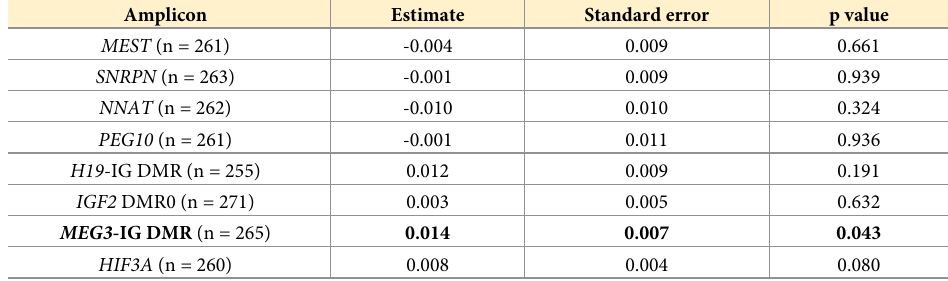
Table 2. Multivariable regression analysis using beta model: sperm DNA methylation in relation to donor’s body mass index. Amplicon